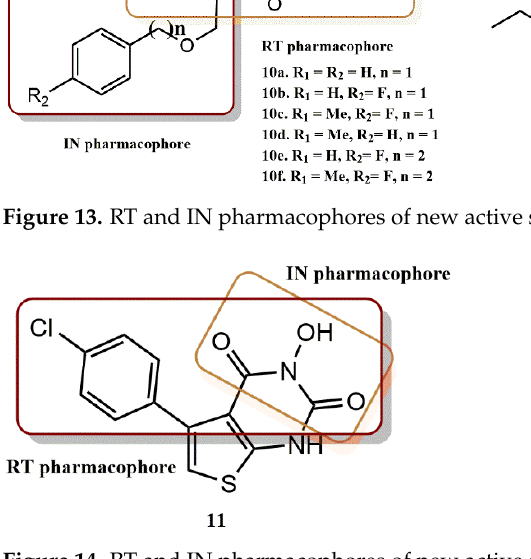
Figure 14. RT and IN pharmacophores of new active synthesized compound 11 .